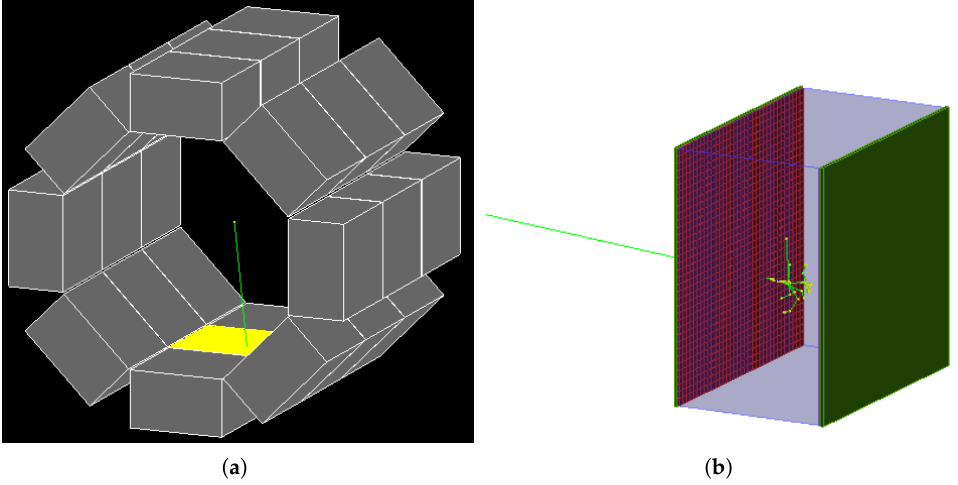
Figure 1. Representation of the simulated calorimeter. A set of 24 large crystals are arranged around the vertex. Inner and outer surface of each crystal are covered with SiPMs. ( a ) Total View. ( b ) Single Crystal. Every crystal features its independent readout on the inner (facing the centre of the octagon) and outer surface. The lateral surfaces are sealed with a thin sub-millimetre aluminum layer to protect the crystal itself and avoid optical